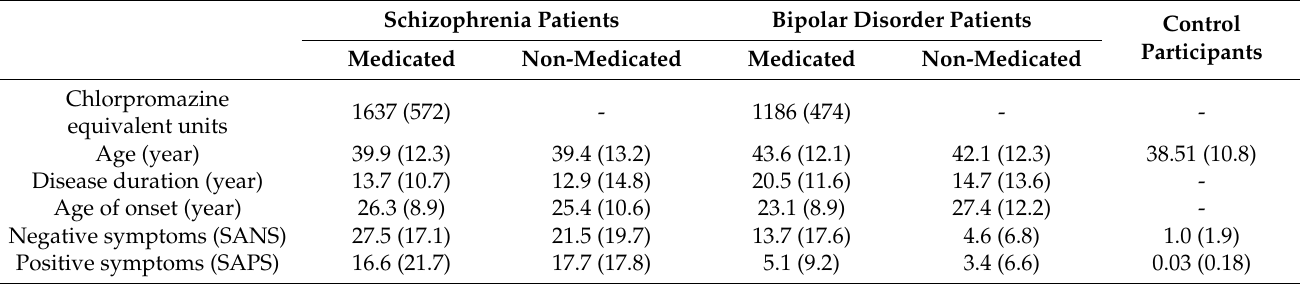
Table 1. Clinical, psychiatric, and neuropsychological profile of medicated (M) and non-medicated (NM) schizophrenic and bipolar patients, and control participants, as well as the current dosage of medication outlined in S4 of the Supplementary Materials, expressed in chlorpromazine equivalent units (group means and standard deviation).